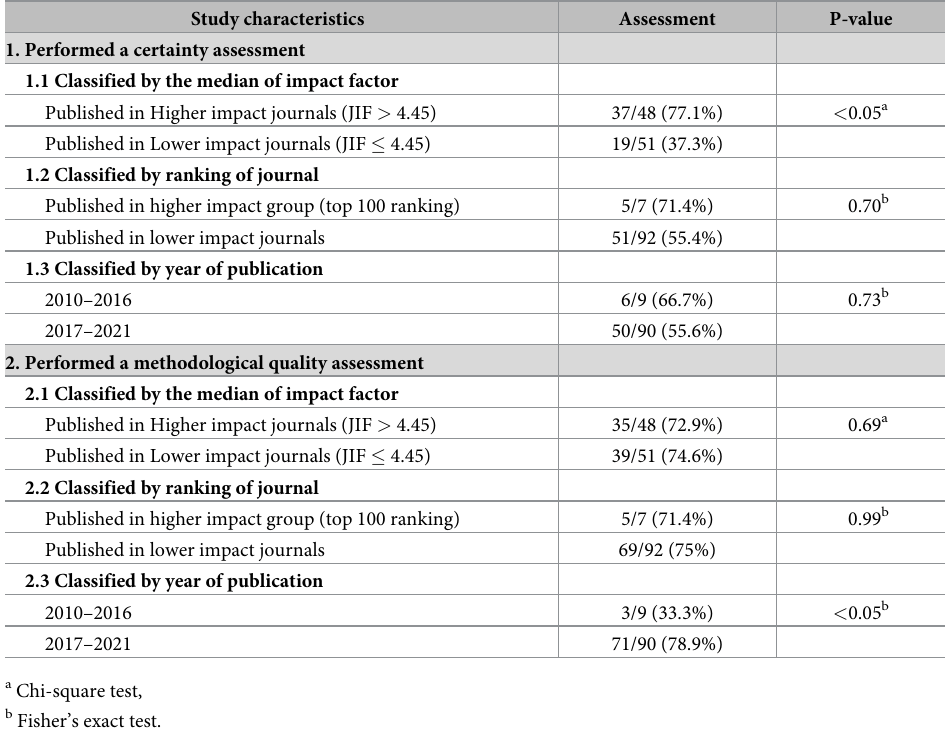
Table 2. Certainty and methodological quality assessment in included